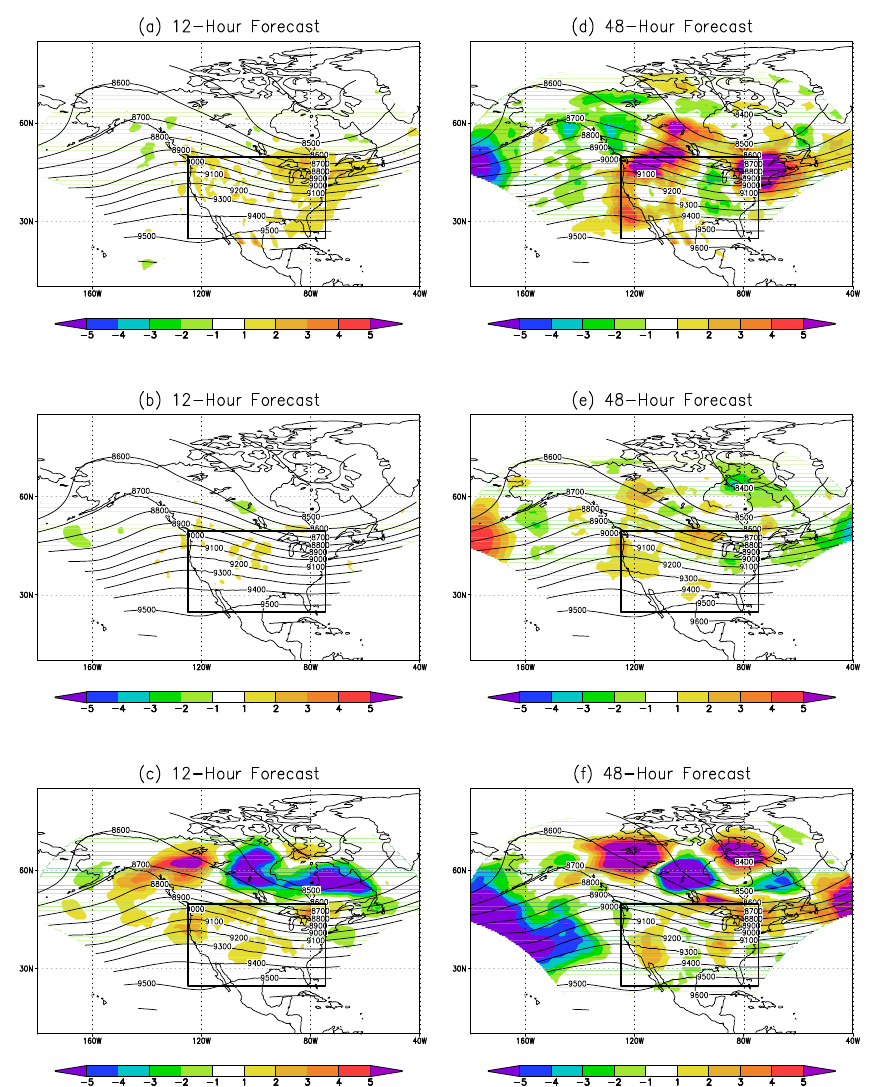
Fig. 6. The difference between the root-mean square errors of the geopotential height forecasts at the 300hPa level for the different config- urations of the analysis system at 12-h and 48-h lead times. Shown are the difference between the forecasts started from the global analysis and the limited area analysis of Strategy 1 ( a and d ), from the limited area analyses of Strategies 1 and 2 ( b and e ), from the limited area analyses of Strategies 2 and 3 ( c and f ). Where the values are positive the forecast from latter analysis is more accurate. Also shown is the mean flow at the 300hPa level for the ”true states“ in the verification period